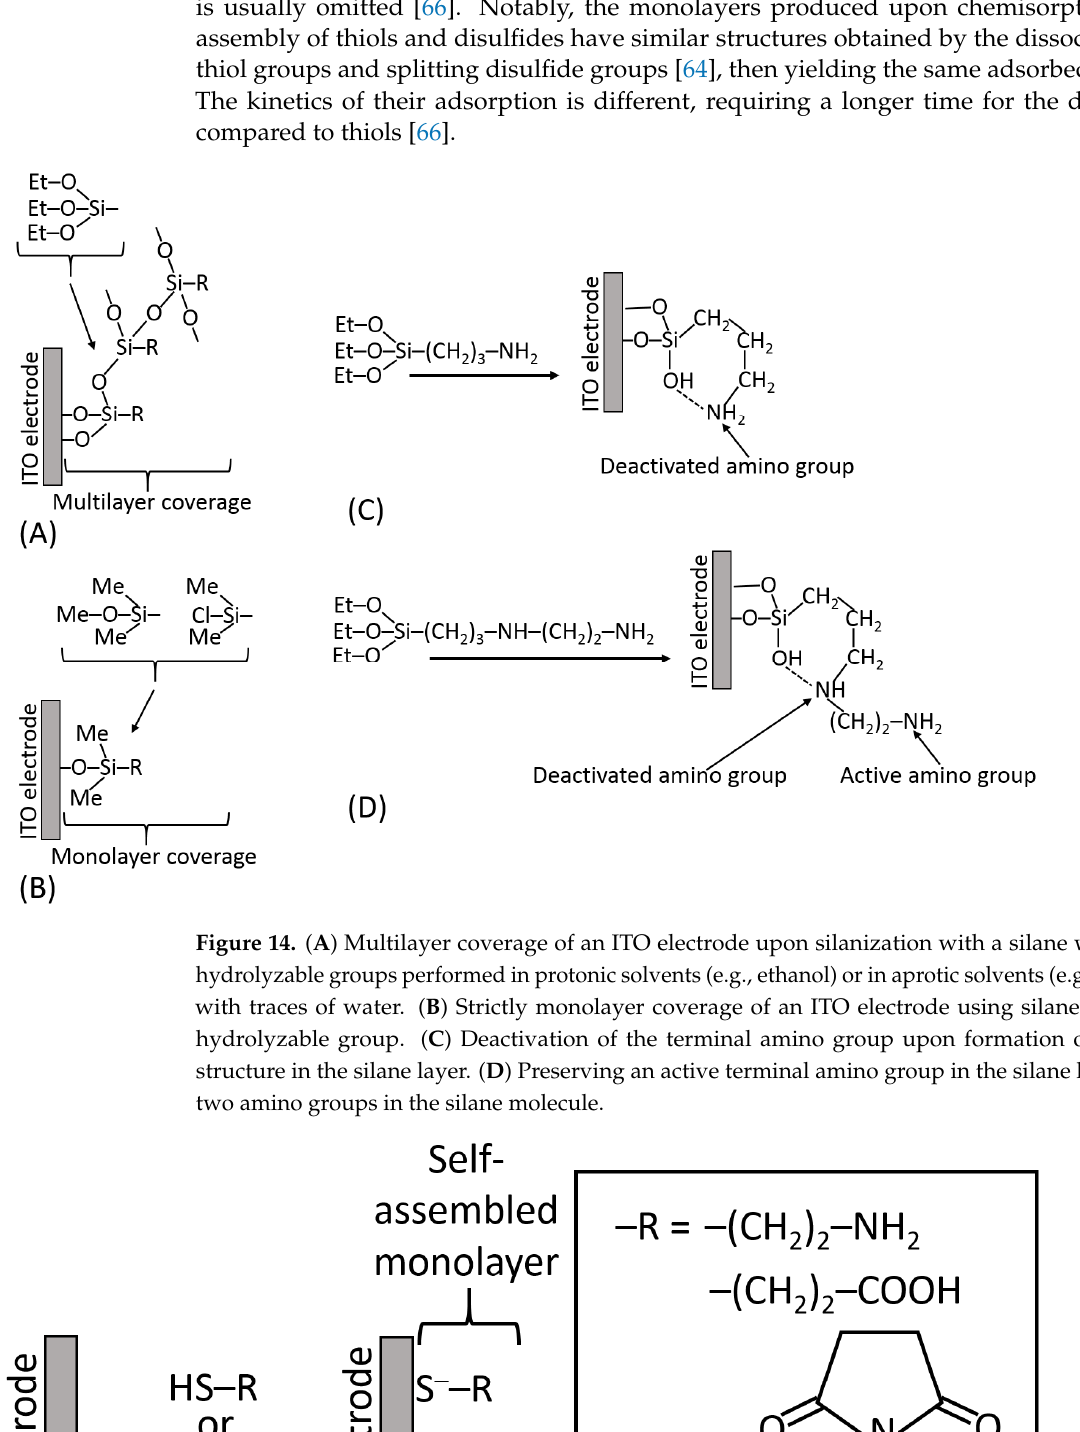
Figure 13. ( A ) Schematically shown silanization of an indium tin oxide (ITO) electrode used in elec ‐ trochemical biosensors. Note that glass surfaces can be modified similarly, while being used in op ‐ tical biosensors. ( B ) The ITO electrode deposited onto a glass slide as a thin conducting film (note a rigid support for the ITO electrode). ( C ) The ITO electrode deposited onto a polymer film as a thin conducting film (note a flexible support for the ITO electrode).